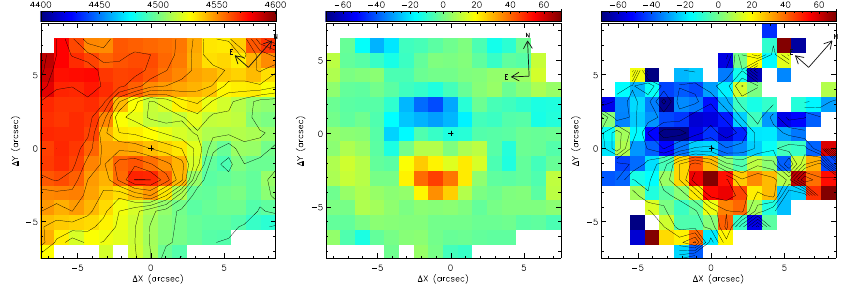
Fig. 6. Mrk 348: the MPFS data: velocity (cid:12)elds in H (cid:11) (left), residual velocity map in H (cid:11) (middle), and [O III] velocity map